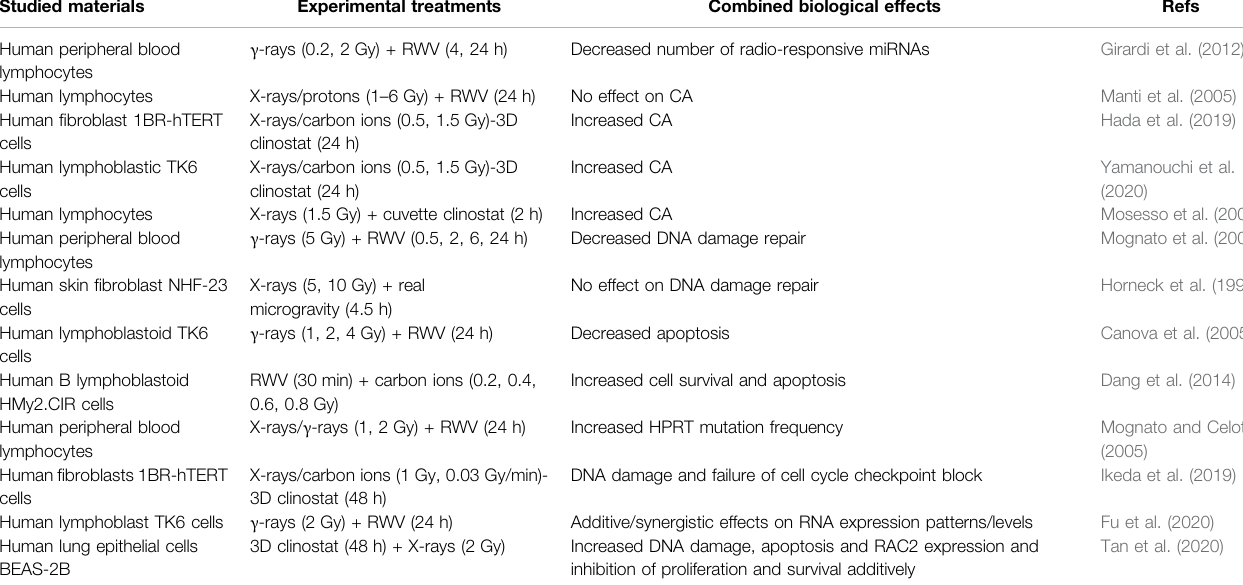
TABLE 3 | Studies reporting the combined effects of space environment in human